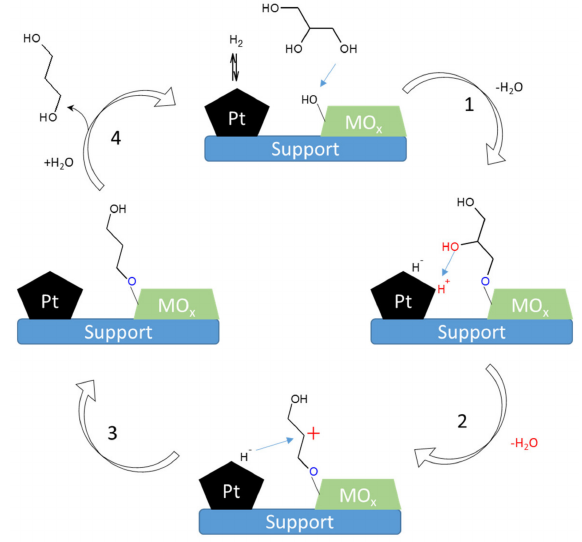
Figure 9. Proposed mechanism for 1,3-Propanediol (1,3-PDO) production in the presence of oxophilic metals (MO x ) and Pt as the metallic